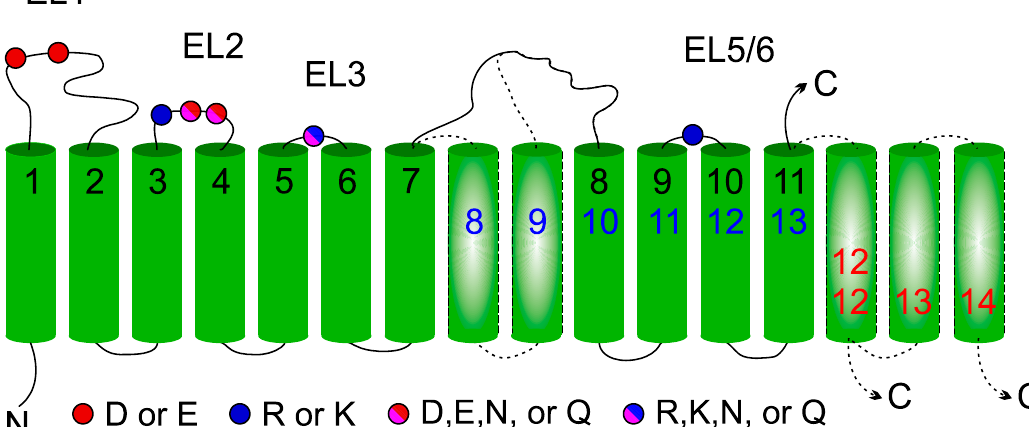
Figure 7. General membrane topology model of glycosyltransferase-C members. Location of the four conserved extracytoplasmic loops in the GT-C families are indicated by color-coded balls representing acidic amino acids. The 11 TMDs (numbered in black) present in all GT-C members are depicted. Inserted TMDs (in broken lines) increase the number of TMDs to 13 (blue) or to 12 / 14 with the C-terminus in the cytoplasm (red).